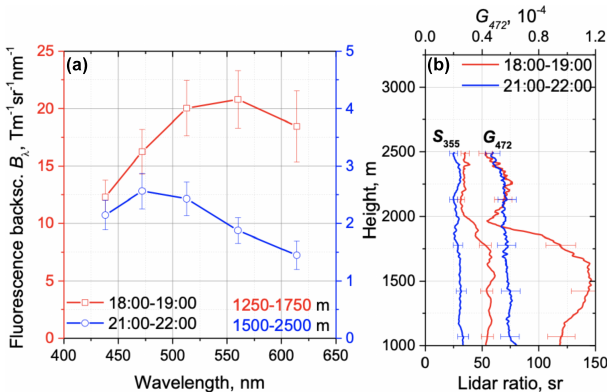
Figure 8. (a) Spectra of fluorescence backscattering B λ on 17 Au- gust 2022 for the 18:00–19:00 and 21:00–22:00UTC periods. Re- sults are averaged within the 1250–1750 and 1500–2500m height ranges respectively. (b) Profiles of lidar ratio S 355 and fluorescence capacity G 472 for the same temporal